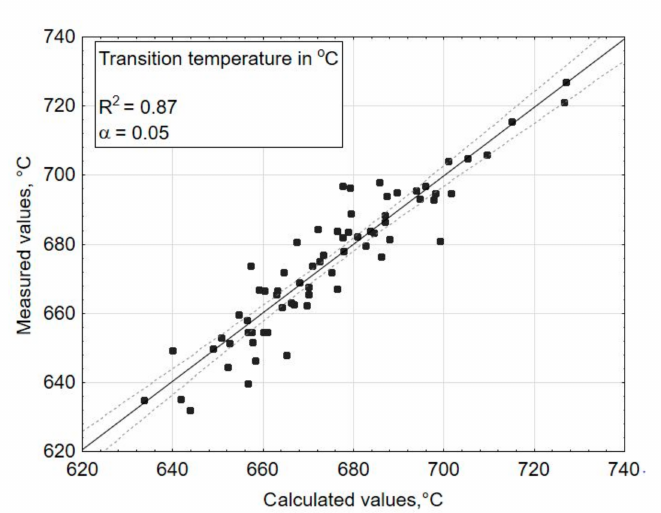
Figure 4. Comparison of the measured values (experimentally tested) with the estimated values (calculated using the chosen mathematical model)—for a dependent variable: transformation tem- perature (Tg) in ◦ C.